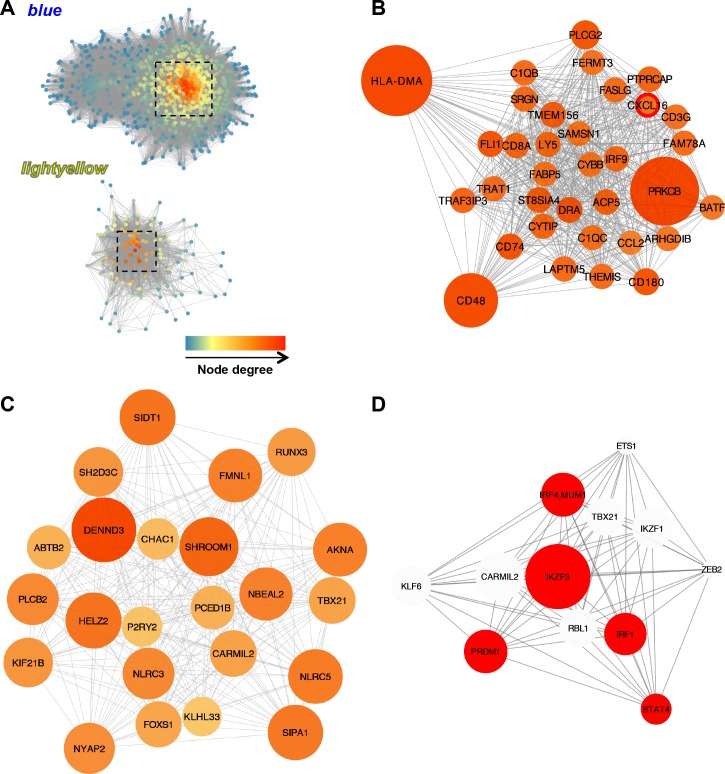
“Hub” gene and neighbor identification in the blue and lightyellow modules.(A) Network visualization of the blue and lightyellow modules (n = 1,195 genes and n = 130 genes, respectively). Highly connected, putative “hub” genes within the module are shown in the squared area. “Hub” genes were selected based on a module membership (MM) value ≥ 0.90, a p-value < 0.05 and gene significance (GS) ≥ 0.5. Node color reflects node degree (number of connections to other genes in the network), where darker reds indicate a higher degree. Network analysis was performed using the NetworkAnalyzer tool in Cytoscape. (B) CXCL16 first neighbors as determined by network analysis of the blue module. CXCL16 was identified as a “hub” gene within the blue module and several of its neighbor genes are involved in immune-related pathways such as CCL2, BATF, CD3G, FASLG, IRF9, CD8A, THEMIS, among others. Node color and size have been mapped to reflect node degree, where darker reds and larger nodes indicate a higher degree. (C) “Hub” genes in the lightyellow module network. (D) “Hub” transcription factor genes belonging the green module derived from the transcription factor network constructed from stallions carrying the CXCL16S allele (homozygous and heterozygous). Node size reflects node degree (number of connections to other genes in the network). Transcription factors identified as differentially expressed between stallions homozygous or heterozygous for CXCL16S and those homozygous for CXCL16R are colored in red. Interestingly, transcription factors that were over-represented during long-term EAV persistence are among the “hub” transcription factors identified in stallions homozygous or heterozygous for CXCL16S.